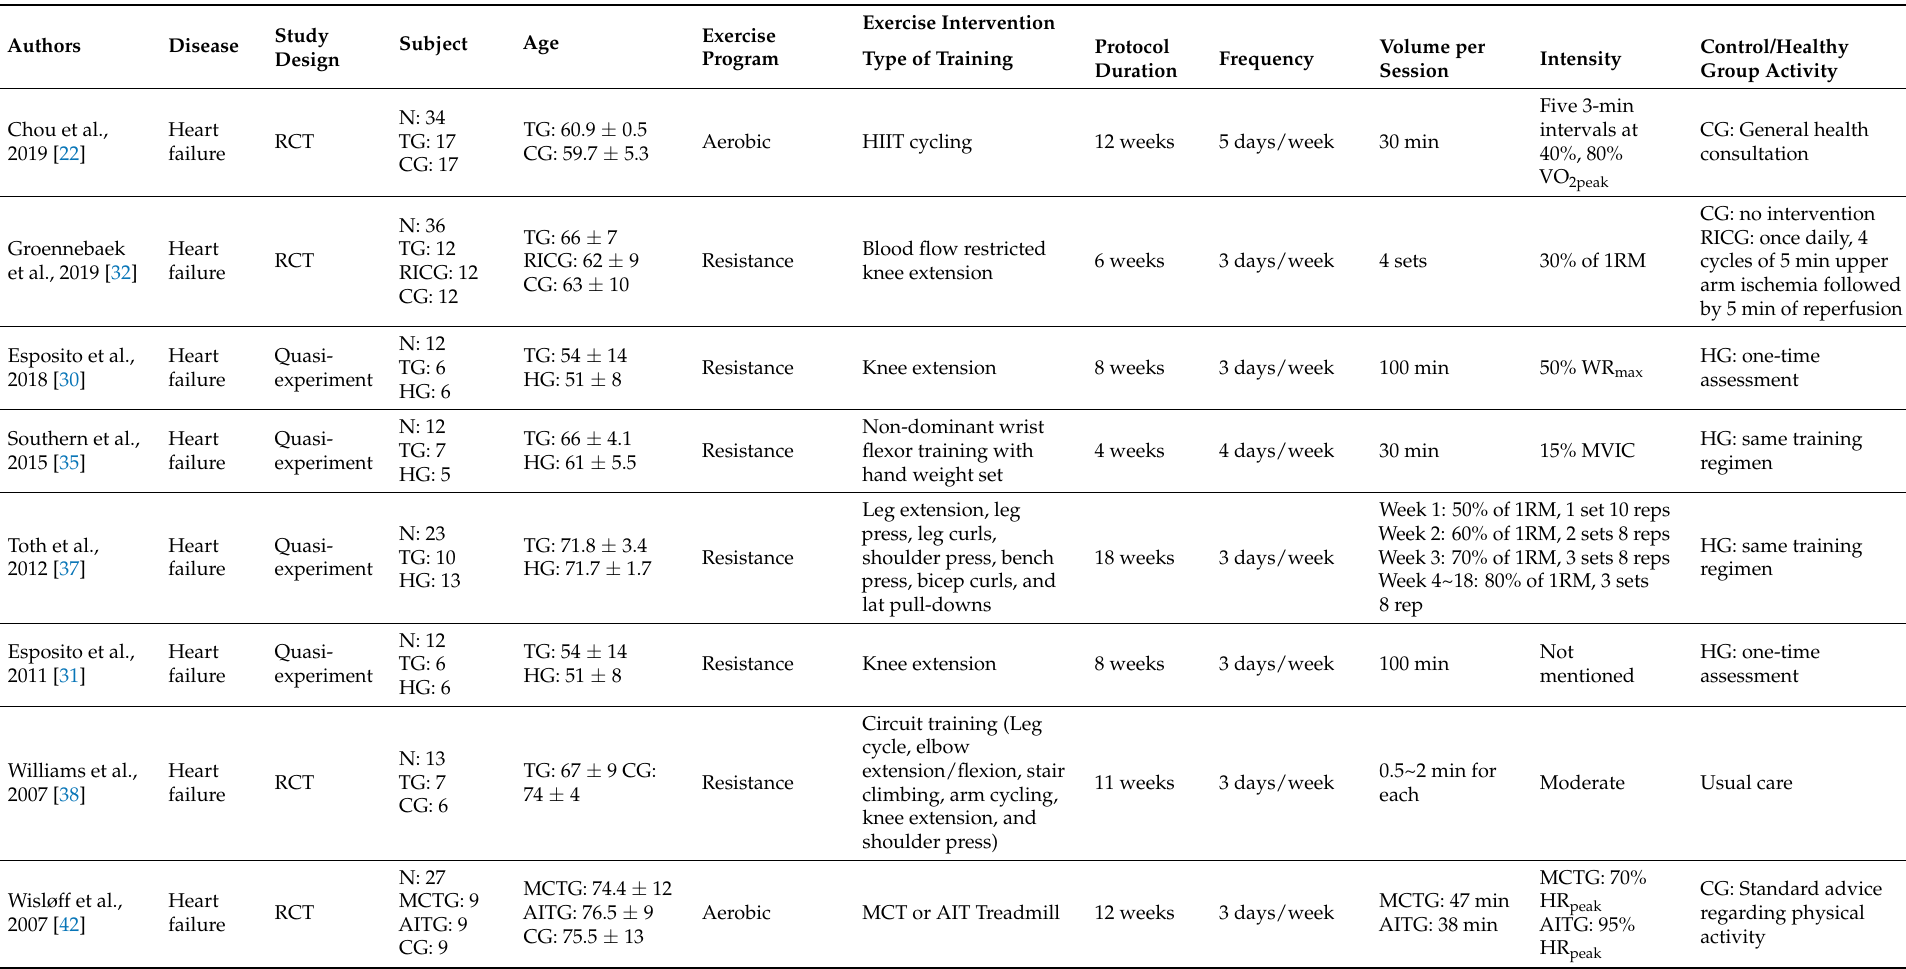
Table 3. Summary of included studies ( n =